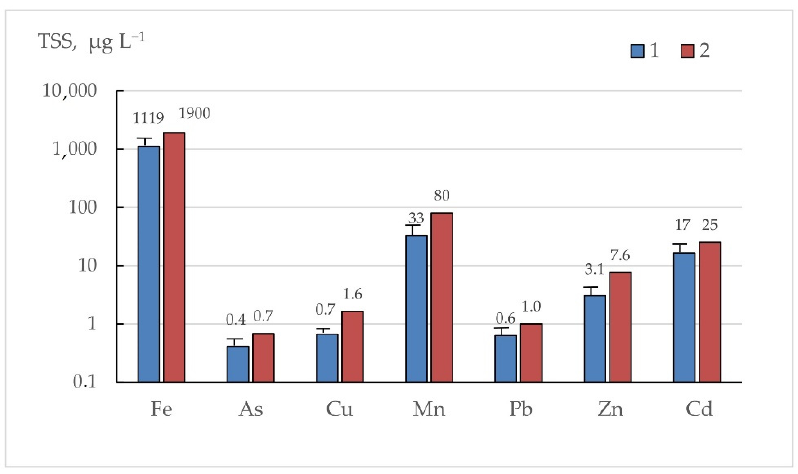
Figure 5. Content of insoluble form of elements in river waters (logarithmic values): 1—Ob River, summer–autumn low water 2020 (our data); 2—Arctic rivers of Eurasia average (data from [22] were used). Error bars represent 1 SD.